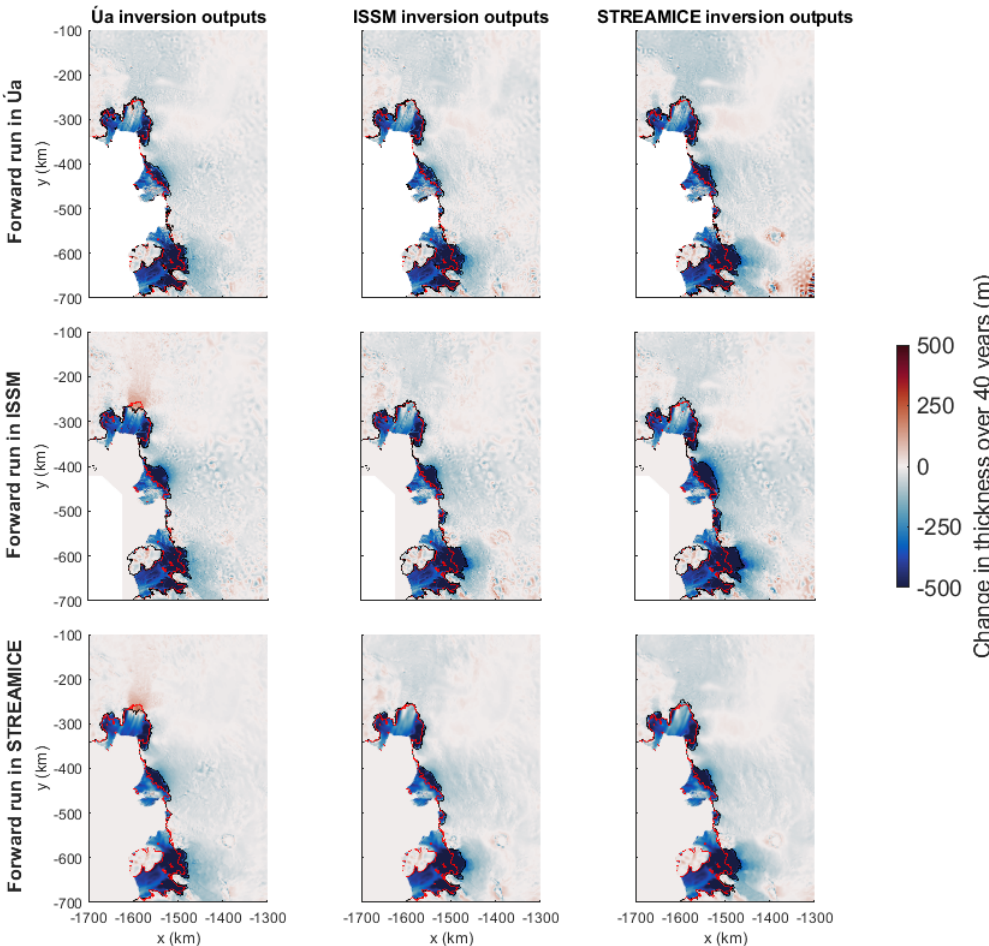
Figure 7. Thickness changes after 40 years of simulation using the rate factor and basal sliding coefficient fields resulting from each of the three model inversions. The initial grounding line position is indicated in red and the final position in